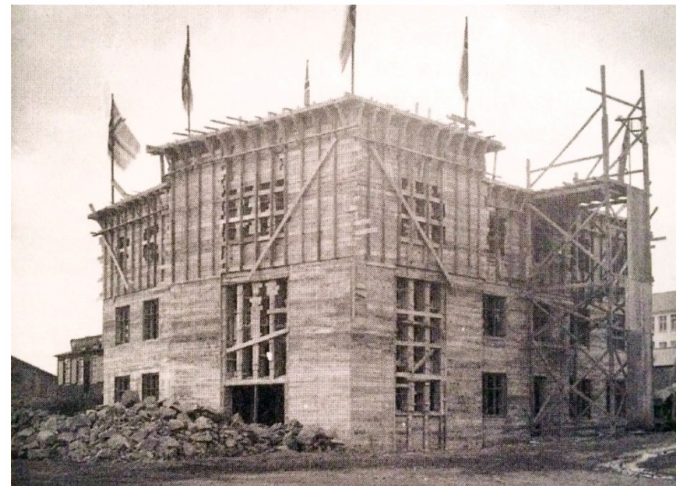
Figure 9. Reykjav í kurm ó t [ Formwork of Reykjav í k ]. Reprinted from: Hörður Á g ú stsson, Í slensk byggingararfleifð I. Á grip af h ú sagerðarsögu 1750 – 1940 , Reykjav í k: H ú safriðunarnefn r í kisins, p. 326. The original picture is by Magnus Ó lafsson